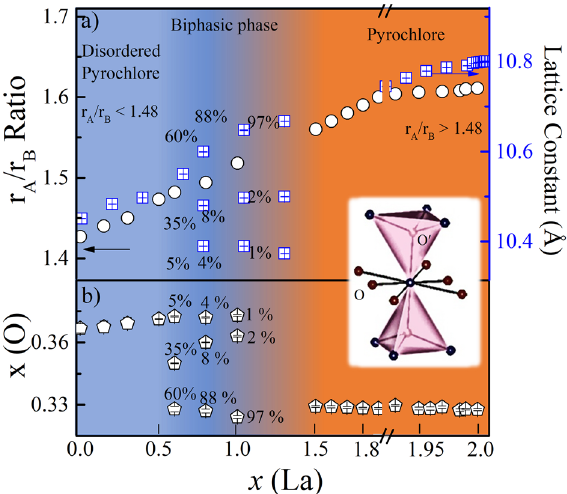
Figure 1. ( a ) Variation in Radius ratio ( r A / r B ) (Left) and lattice constant (Right) as a function of La substitution for Dy 2 − x La x Zr 2 O 7 ; (0 ≤ x ≤ 2). We have extended the scale between x = 1.9–2.0 for the better clarity. ( b